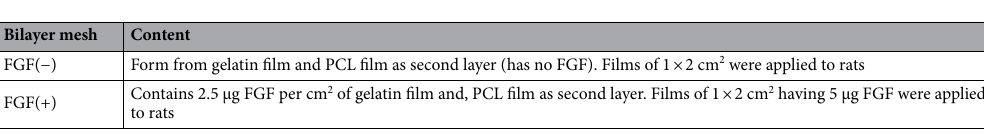
Figure 1. Design of study ( a ) bilayer meshes, ( b ) preparation of esophagial defect, ( c ) the mesh was placed as a patch over the esophageal opening, then the edges of the esophageal opening were secured with interrupted sutures, ( d ) syhngomanometer device.